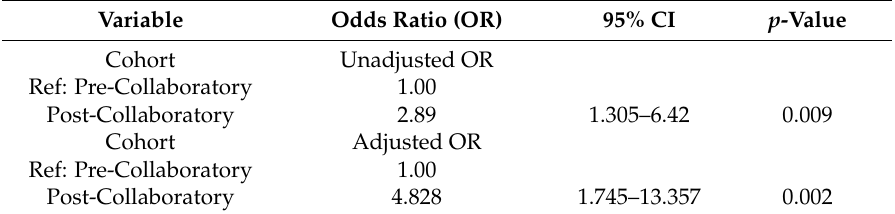
Table 1. Comparison of Likelihood to Submit in 6 months: Pre- and Post-Collaboratory